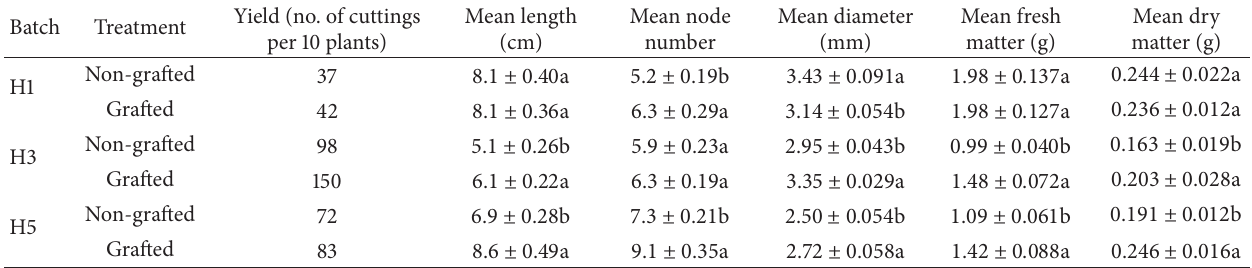
Table 1: The productivity of and quality of cuttings from non-grafted and grafted chrysanthemum “Jinba”. Yield (no. of cuttings Mean length Batch Treatment per 10 plants) (cm) H1